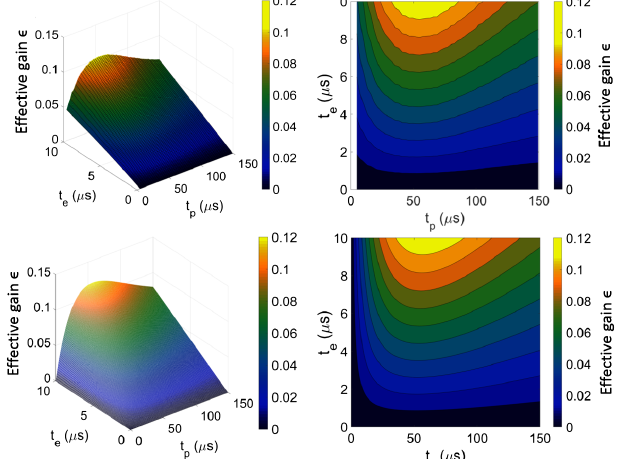
8. Top: Experimental effective gains versus t p and t e for optimized t 0 . Bottom: Simulated effective gains versus t p and t e for optimized t 0 , F ¼ 23 000 and a steady state gain of